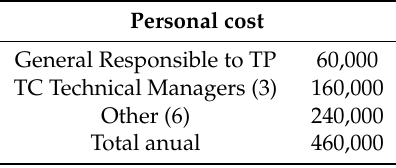
Table 7. Cost of workforce by the project